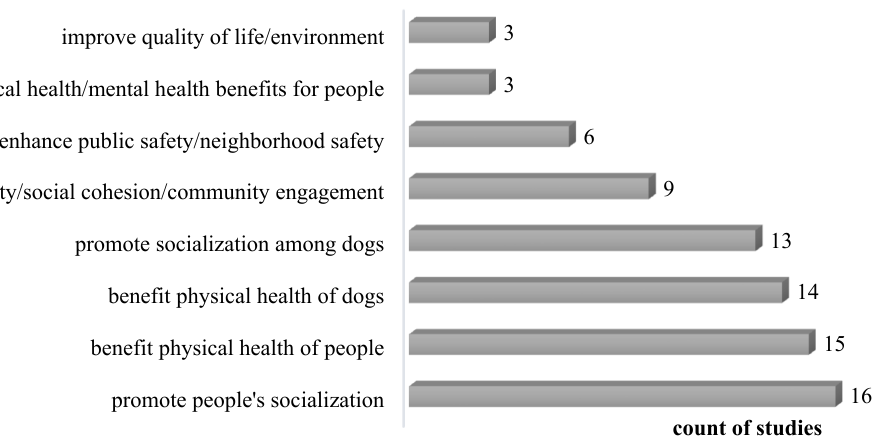
Figure 3. The flow of systematic study following the phases of PRISMA.